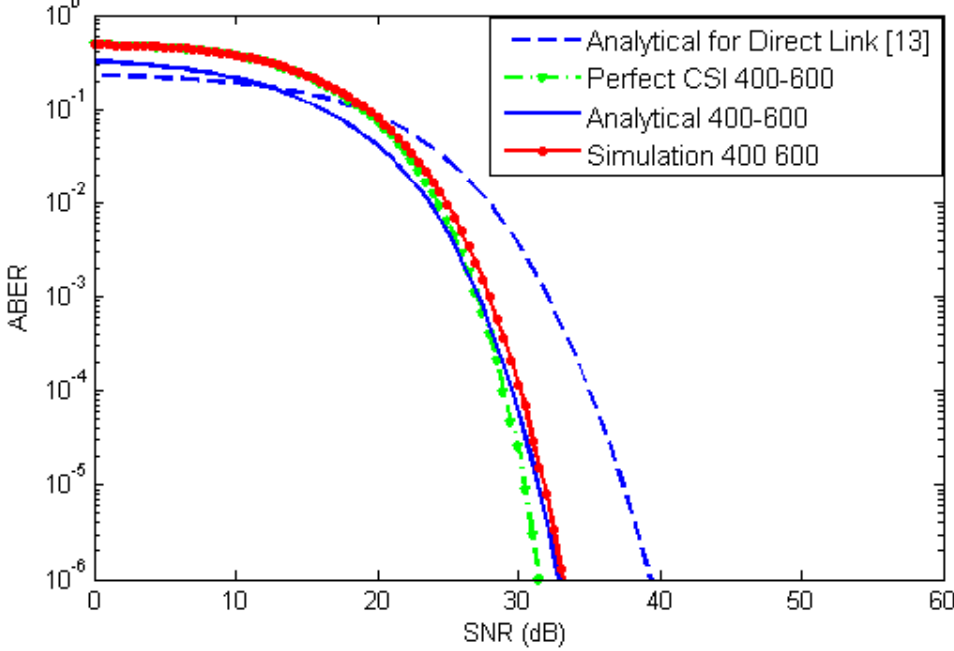
Figure 3. ABER performance for the direct link and a single relay after 400 m from the source, over weak turbulence.